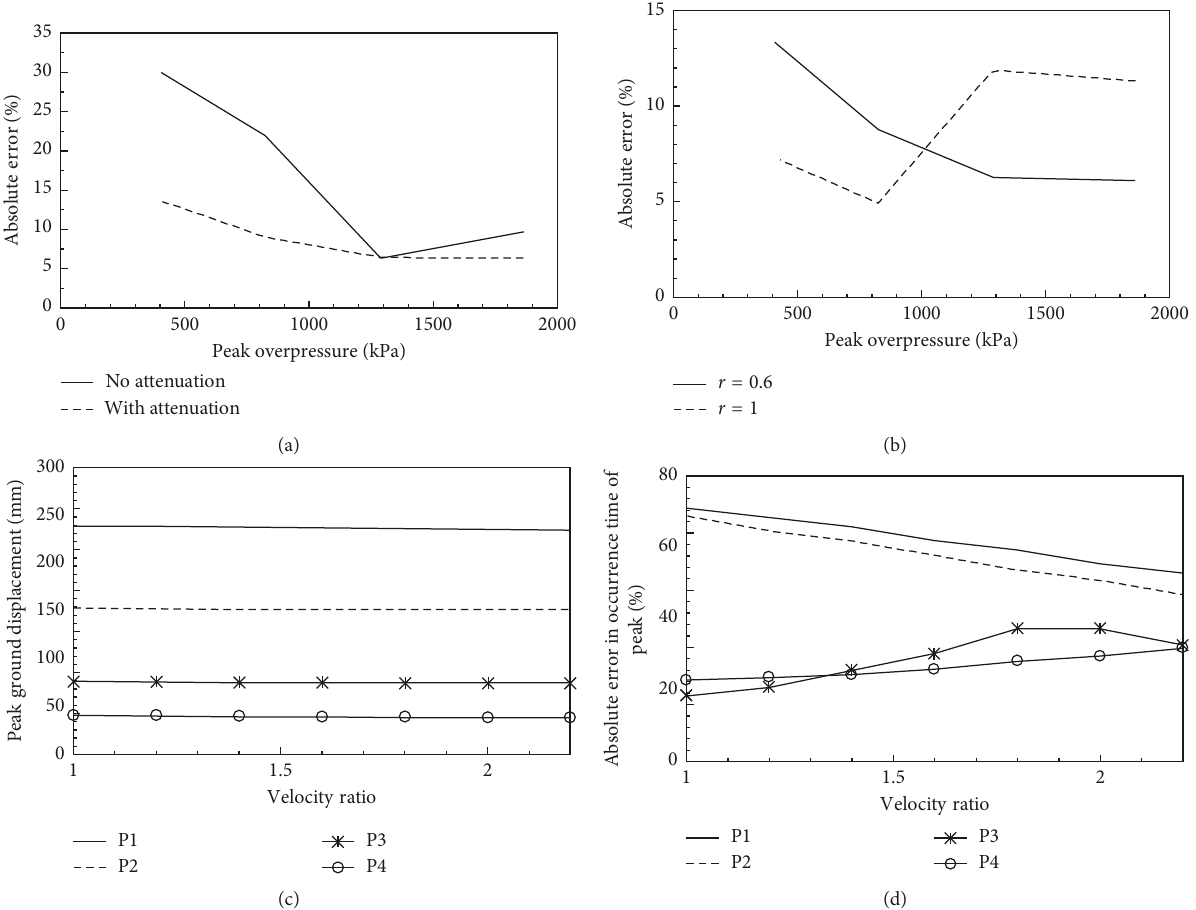
Figure 8: Effect of (a) attenuation; (b) strain recovery ratio; (c) velocity ratio on estimated ground displacement; (d) velocity ratio on time of occurrence of peak displacement.